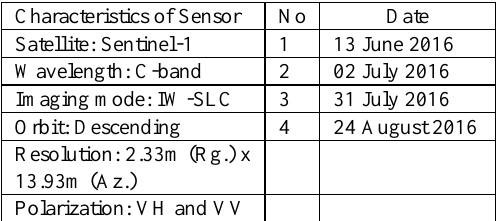
Table 1. Specifications of Sentinel-1